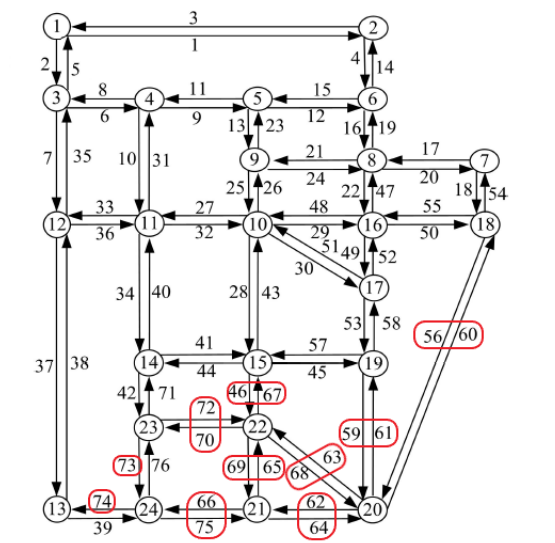
Figure 5. Sioux-Falls Network and uncertain scenario of damage simulated. The (red) rectangles identify the links that are potentially damaged in the uncertain disruption.